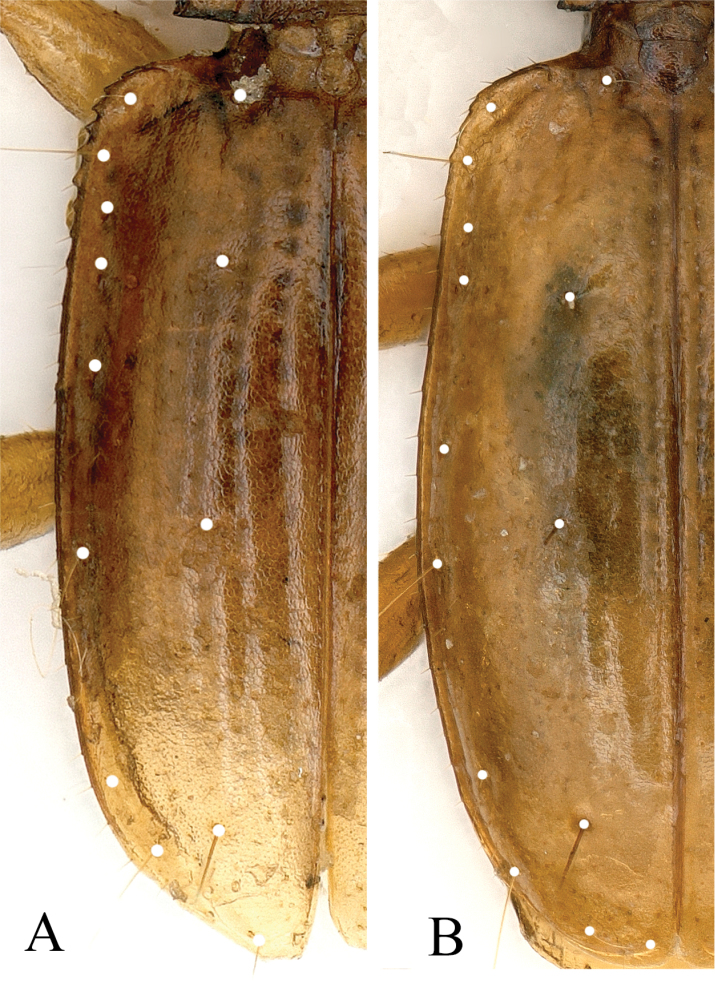
Left elytra of two cave trechines to show chaetotaxy AShenoblemus
minusculus, sp. et gen. nov., male, holotype BWanoblemus
huangshanicus, sp. nov., male, holotype.